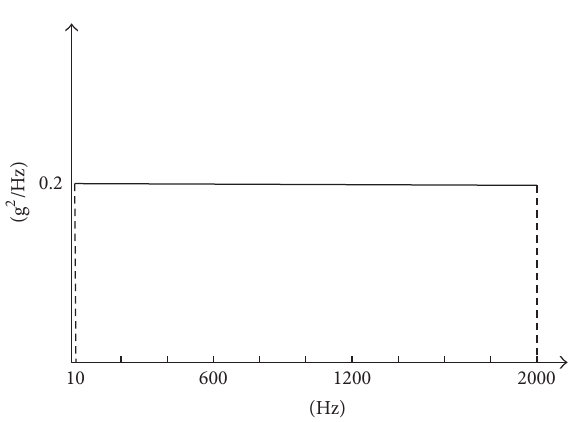
Figure 4: Exaction vibration spectrum, a white noise